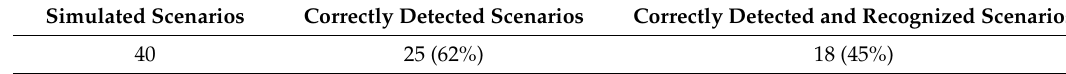
Figure 11. The root detection process of the genetic algorithm. Table 2. Genetic algorithm performances at the scenarios